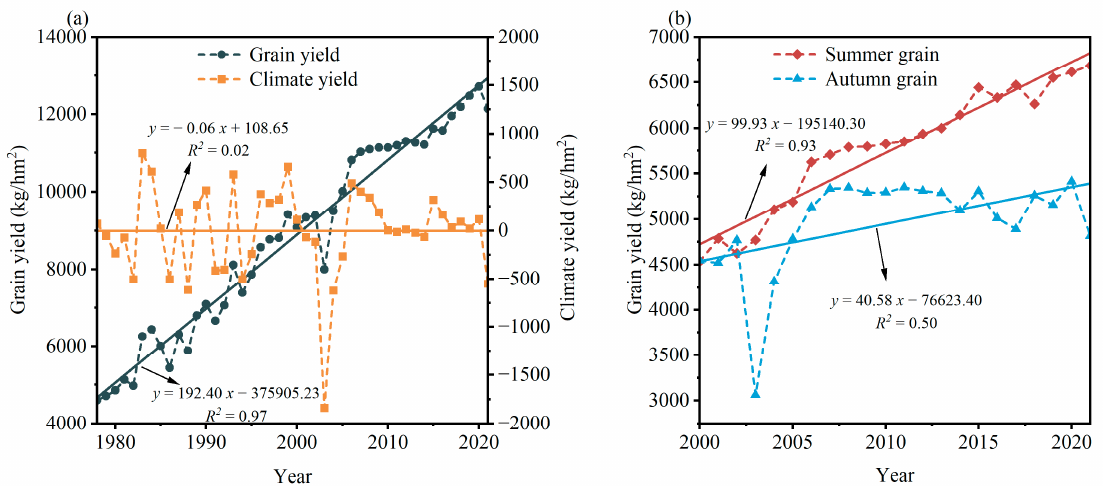
Figure 7. Variation characteristics of grain yield in Henan Province. ( a ) represents the variation characteristics of grain yield and climate yield from 1978–2021, ( b ) represents the variation characteristics of summer and autumn grain yields from 2000–2021.